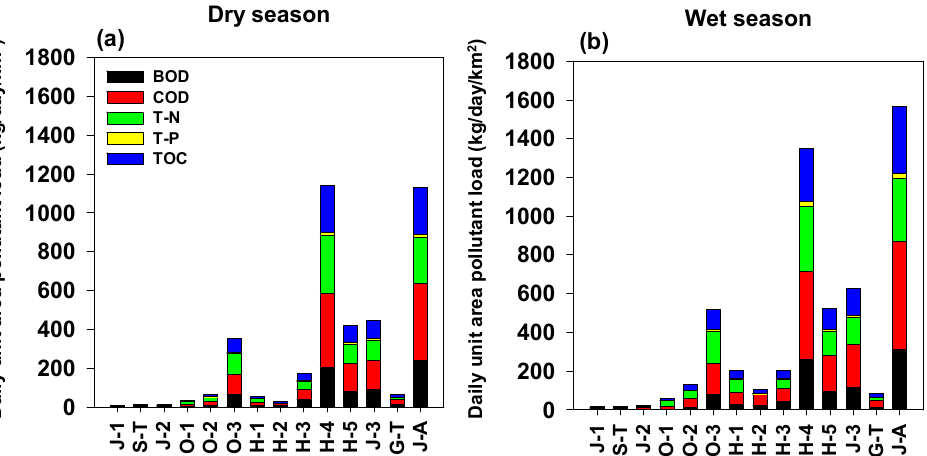
Figure 2. Daily unit area pollutant load at each site during ( a ) dry season and ( b ) wet season.